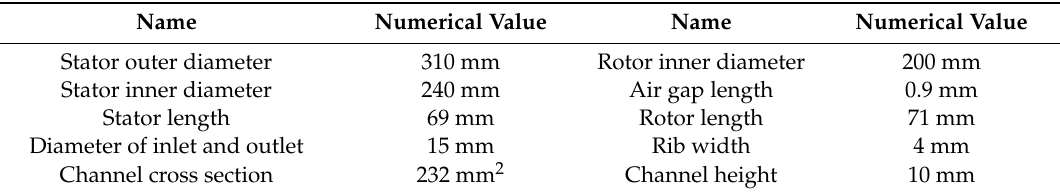
Table 1. Structure parameters of IWM.